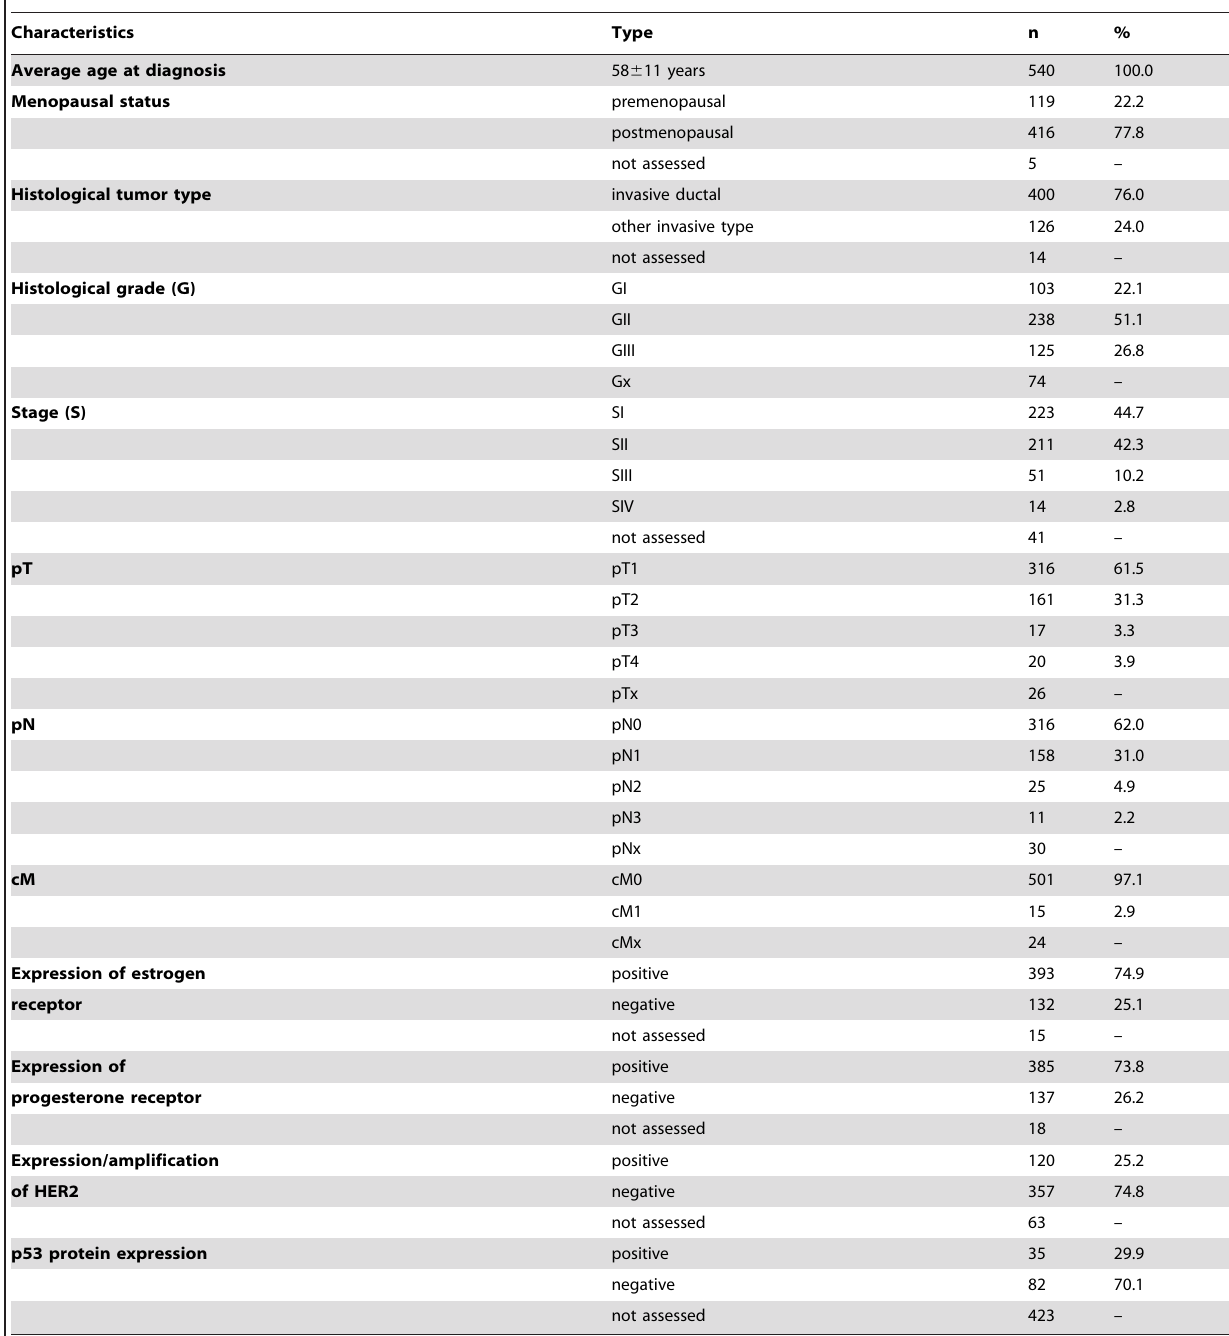
Table 1. Clinical-pathological characteristics of patients.